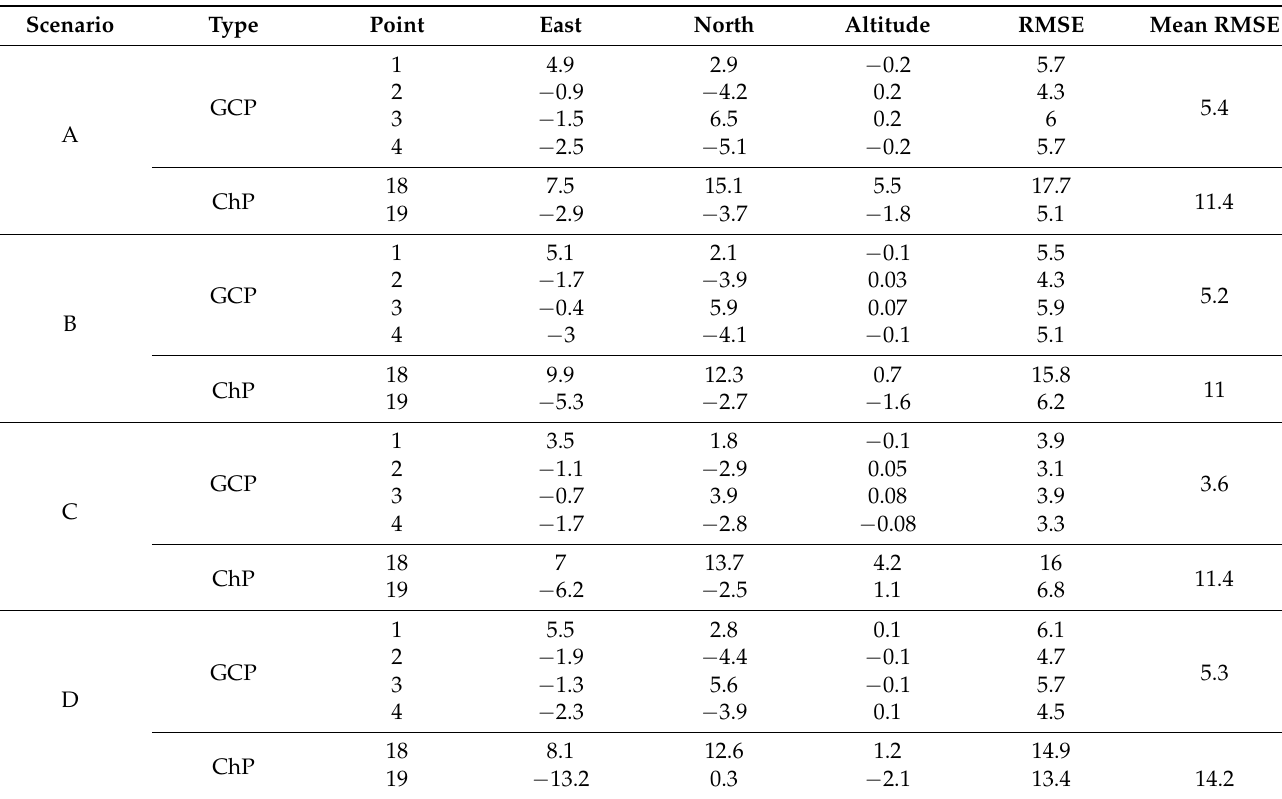
Table 5. Mean RMSE of the GCP and ChP for the four Block 1 scenarios (in